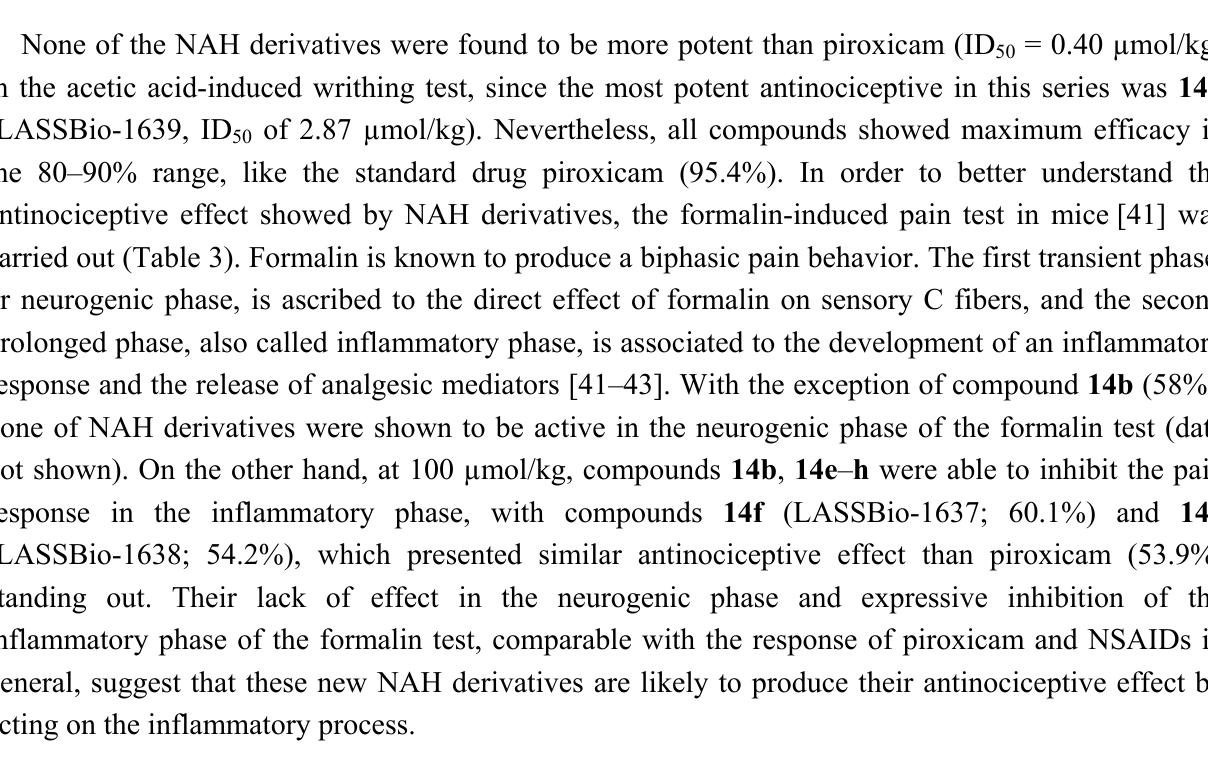
Table 3. Effect of piroxicam NAH analogues ( 14a – h ) and piroxicam (100 µmol/kg, p.o.) on formalin-induced pain test in